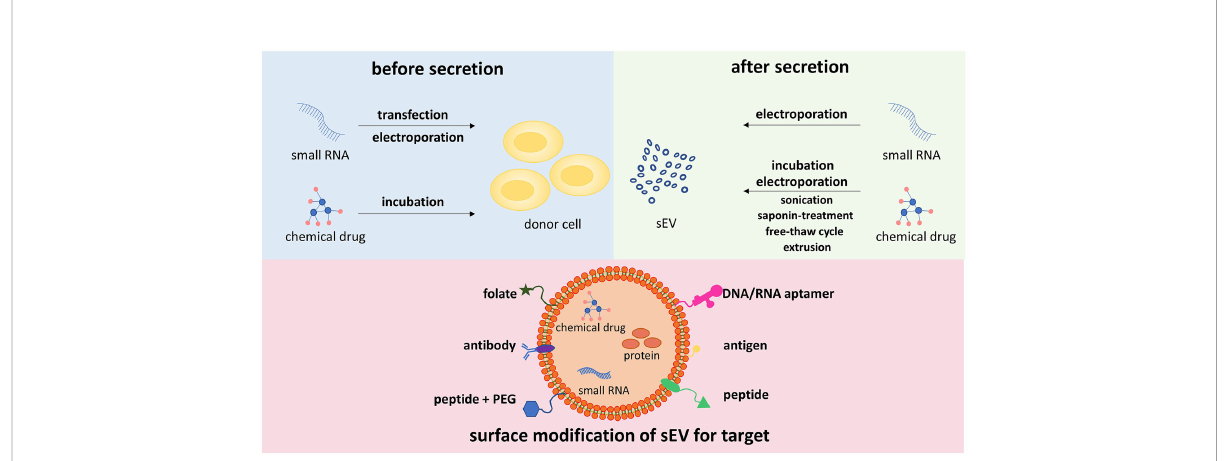
FIGURE 2 Different methods for drug loading into sEVs, and surface engineering for targeting speci fi city sEVs can be uploaded with drugs via two types of methods, introducing drugs into cell origin before sEV secretion and loading drugs into sEVs directly. The former approach includes transfection, electroporation, and incubation. The latter approach consists of electroporation, incubation, sonication, saponin treatment, free – thaw cycle, extrusion, and so on. To enhance targeting activity, the surface of sEVs is modi fi ed to express af fi nity molecules, such as peptides, DNA/RNA aptamers, folate, antibodies, and antigens. sEVs, small extracellular